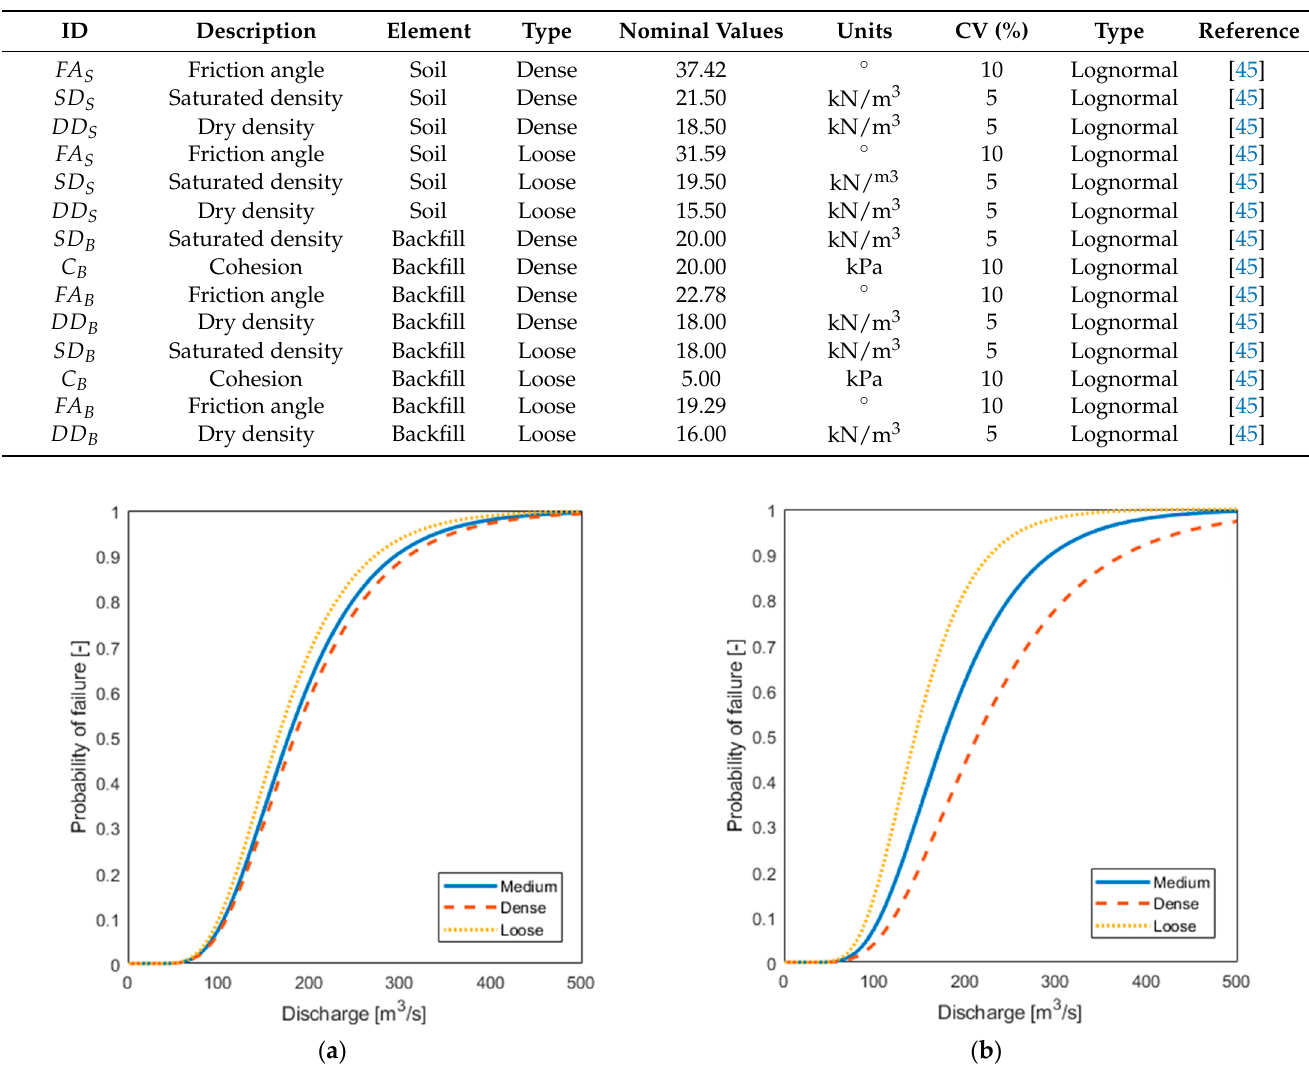
Figure 11. Fragility curves based on the geotechnical uncertainties of: ( a ) soil beneath the foundation; ( b ) backfill.